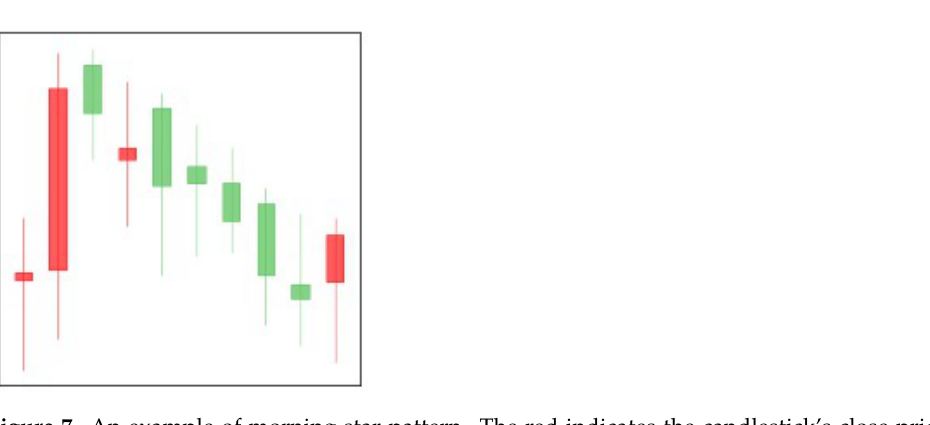
Figure 7. An example of morning star pattern. The red indicates the candlestick’s close price is higher than the open price. The green shows the close price of these candlesticks is lower than the open price.